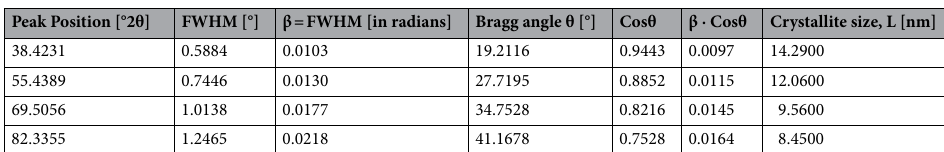
Table 1. The summary of the Scherrer equation data for the milled